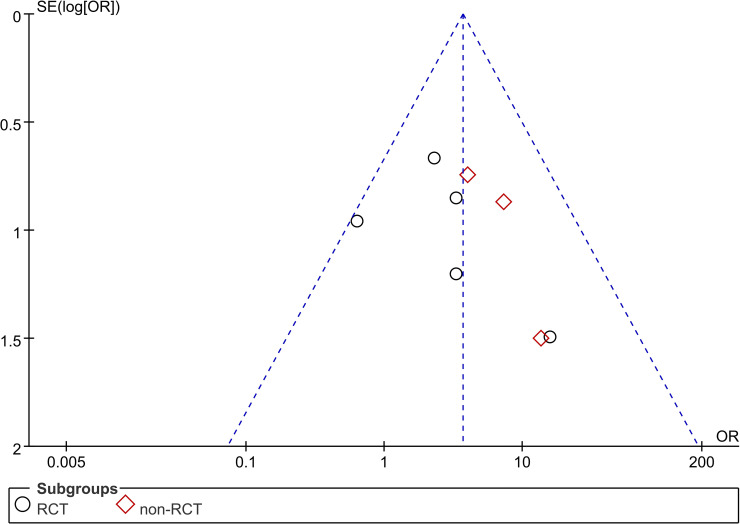
Funnel plot of closure rate between PRP and control group.PRP: platelet-rich plasma; RCT: randomized controlled trial.